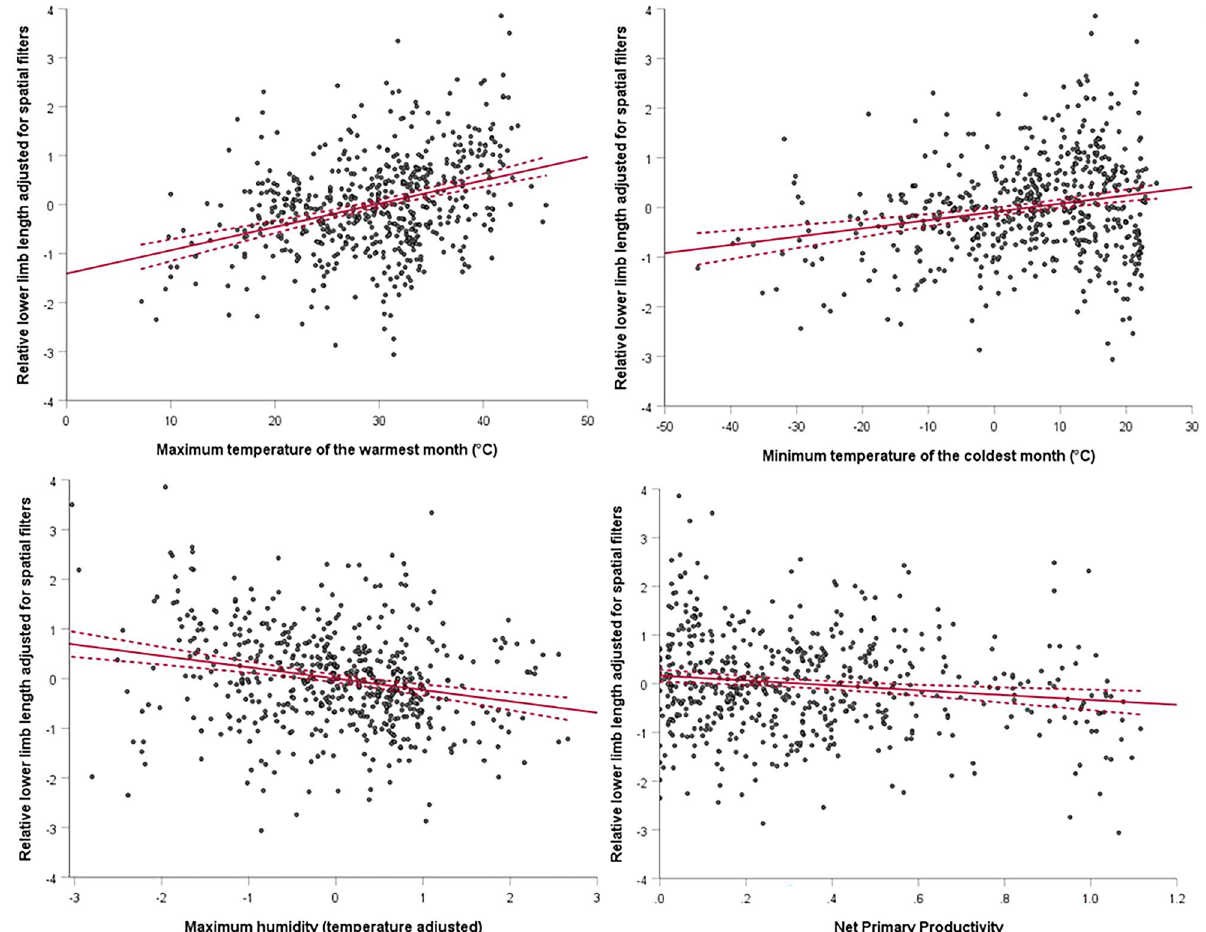
Figure 3. Example scatterplots for male relative lower limb length adjusted for relevant spatial filters, against climatic and environmental variables. Linear regression lines (solid) and 95% confidence intervals (dashed) are shown. Net primary productivity in tonnes of carbon m −2 year −1 × 10 –6